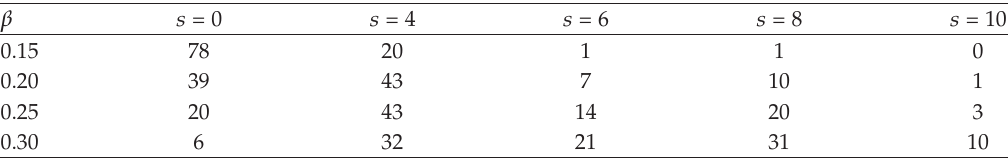
Table 1: Decomposition of the wave function of the ground state of 66 Ge according to its seniority components, in percentage, for di ff erent values of the deformation β